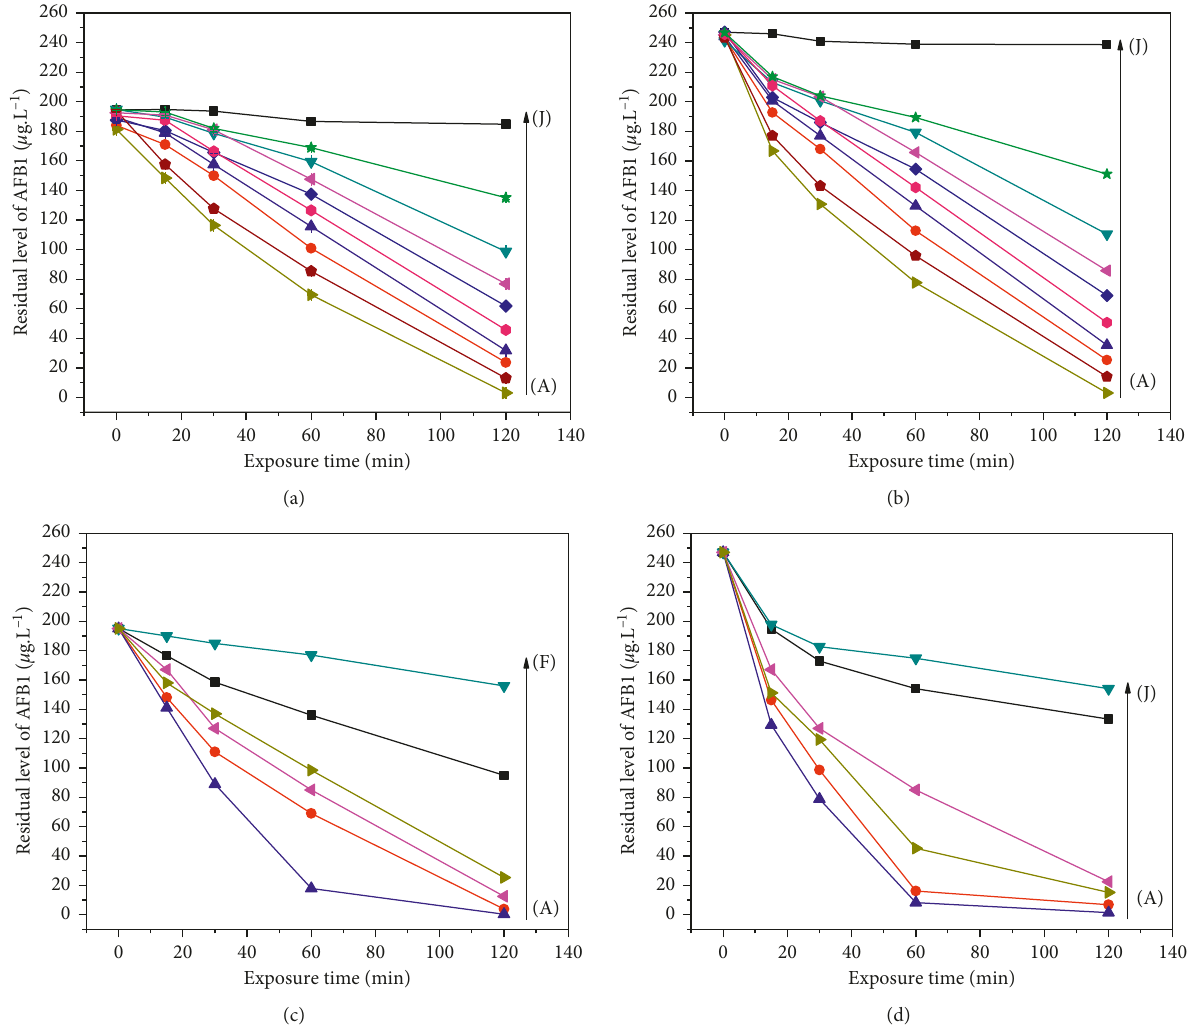
Figure 2: Effect of exposure time when the different aqueous extracts (A: garlic, B: lemon, C: sacred basil, D: black cumin, E: lemongrass, F: ginger, G: clove, H: fenugreek, I: thyme, and J: control) are incubated with standard AFB1 (a) and AFB1-contaminated maize sample (b); effect of concentration (A: 50 mg./L, B: 10mg/L, and C: 1mg/L garlic and D: 50 mg/L, E: 10g/L, and F: 1mg/L lemon) on standard (c) and AFB1-contaminated maize samples